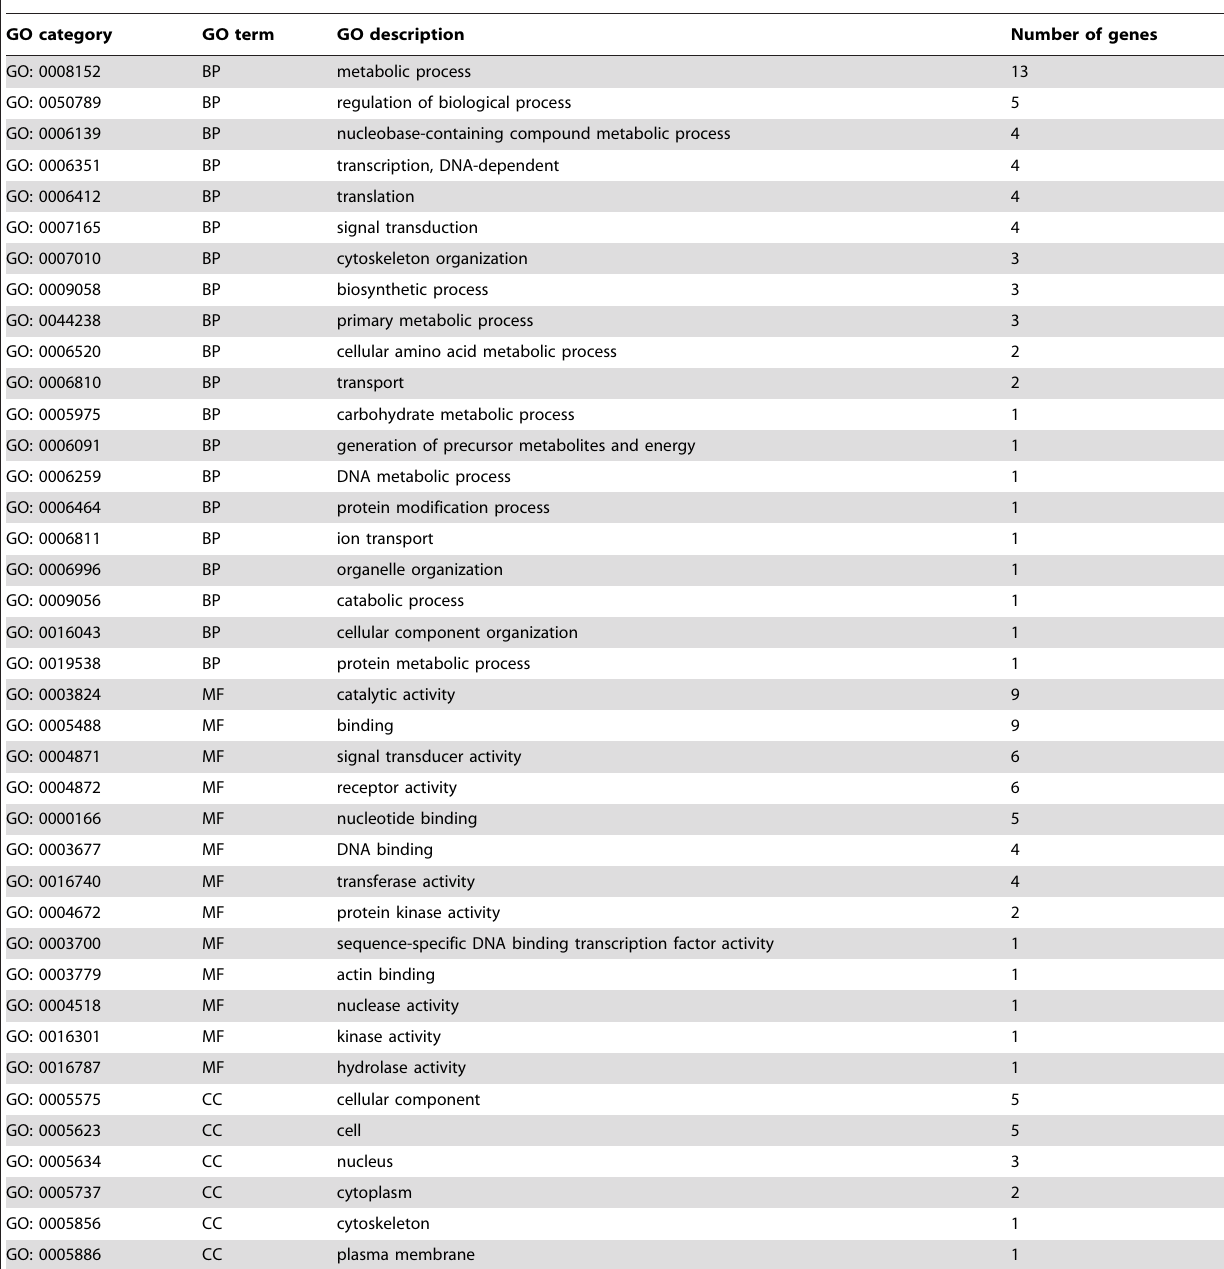
Table 3. Gene ontology (GO) analysis of differentially expressed